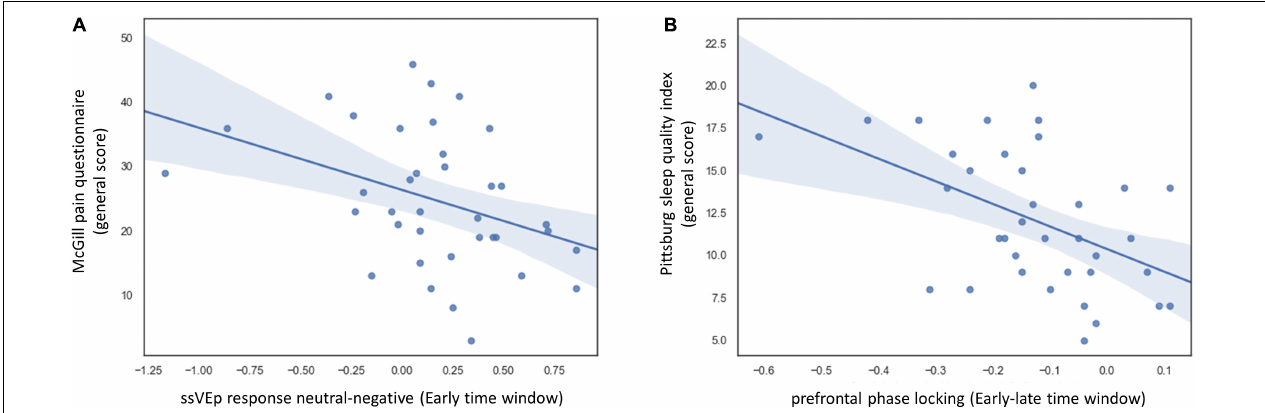
FIGURE 4 | Correlation between task ssVEP indices and disease symptoms in the FMS group. (A) Scatter plot displaying the relation between and the general score of the McGill pain questionnaire and difference in ssVEP response between neutral and negative distractors during the early time window. To make sure that this result could not be attributed to affective symptom severity, we followed up on this analysis using partial correlation, controlling for depression, anxiety, and sleep quality scores. Controlling these variables did not diminish the correspondence between valance specific EEG response and pain severity [R Spearman = 0.43, 95% CI [0.12:0.66], p = 0.01]. (B) Scatter plot displaying the relation between overall sleep quality as indicated by the Pittsburg sleep quality index and the delta between fronto-occipital phase-locking values in the early and late time windows. When controlling for additional clinical variables (anxiety, depression, and pain ratings)